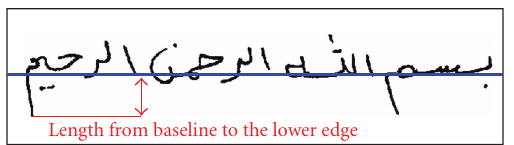
Length from baseline to the lower edge Figure 10: Measuring the length from the baseline to the lower edge.